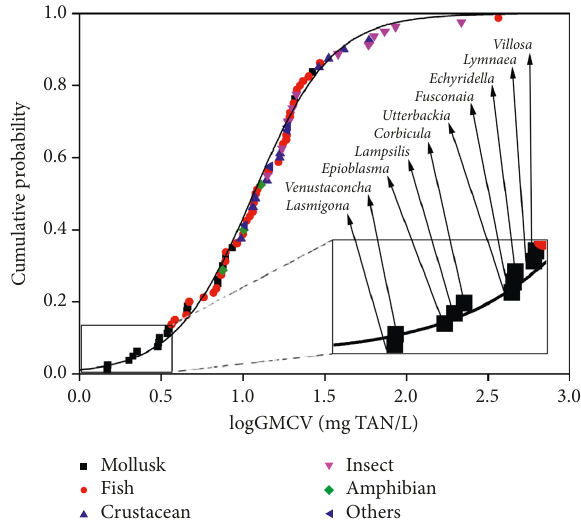
Figure 3: Species sensitivity distributions of ammonia nitrogen. Internal figure: top ten genera of the most sensitive species (all of them are